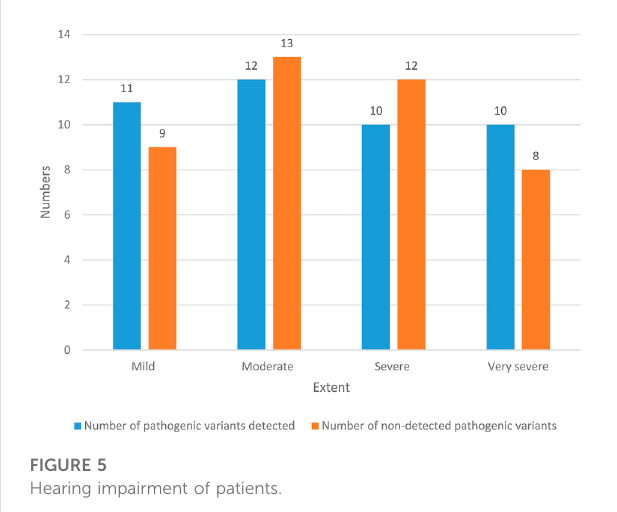
FIGURE 5 Hearing impairment of patients.